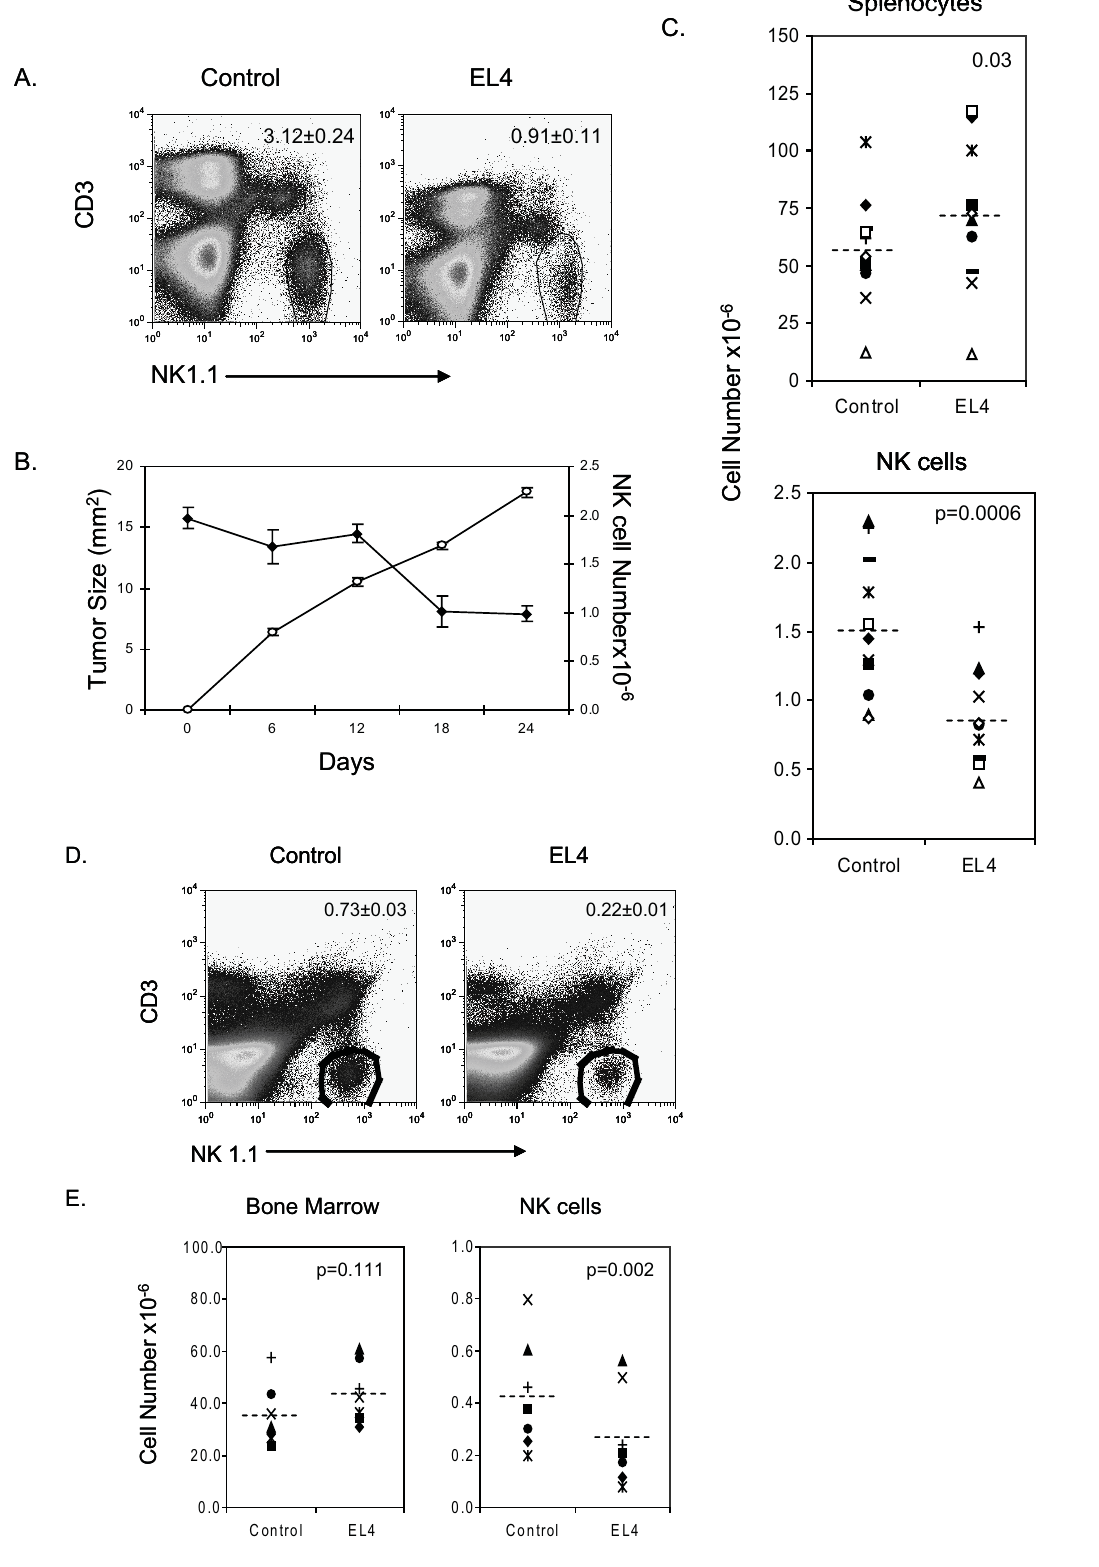
Figure 1. EL4 tumor growth causes a decrease in splenic and bone marrow NK cells. Mice were injected subcutaneously with 5 6 10 6 EL4 cells and compared to mice that received PBS. The number of NK cells was calculated by multiplying the percentage of NK cells by the cellularity of the spleen or bone marrow. A. FACs profile of splenocytes stained with CD3 and NK1.1. NK cells were characterized as NK1.1 + CD3 2 . The percentage